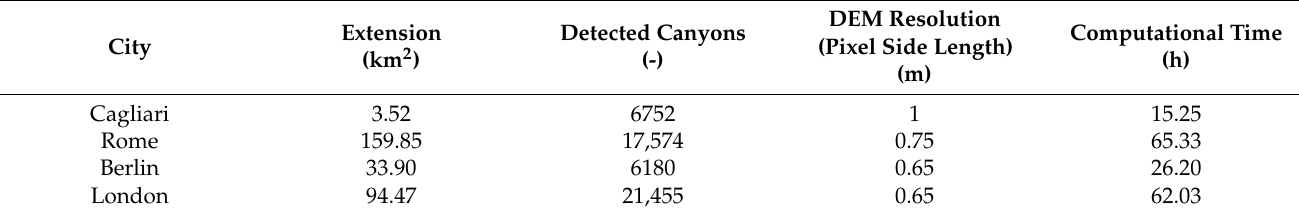
Table 1. Specifications on site characteristics, number of detected canyons, DEM resolution after pre-processing and computational